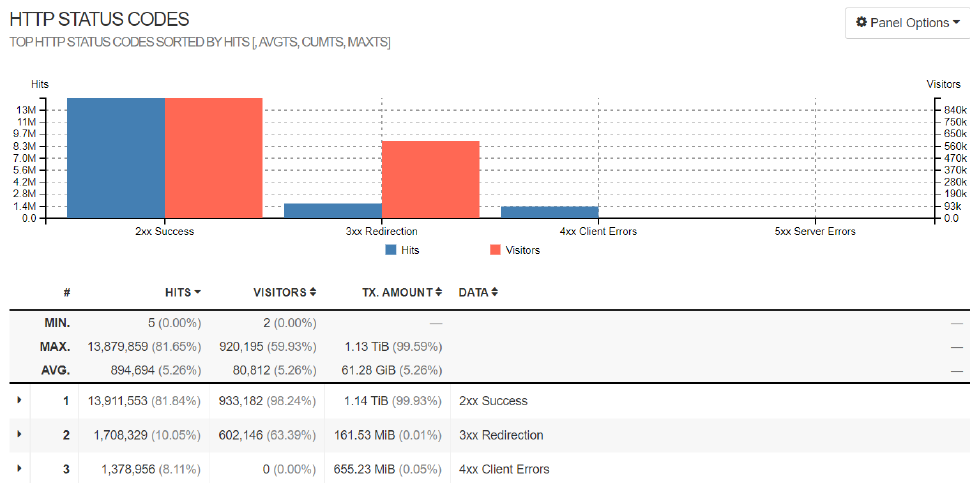
Figure 15. Top HTTP status codes in 2021 sorted by hits.